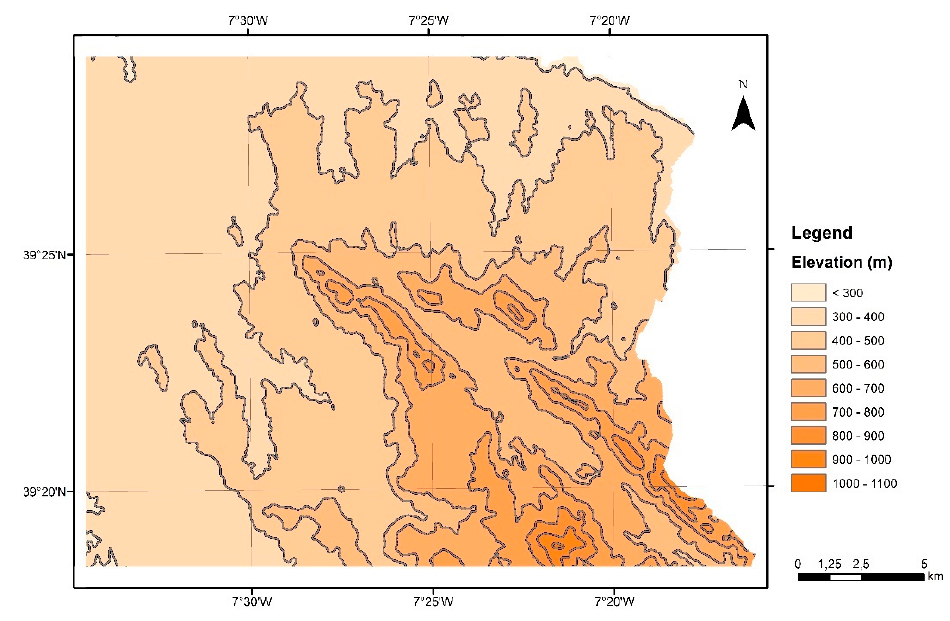
Figure 5. DEM of the study area.